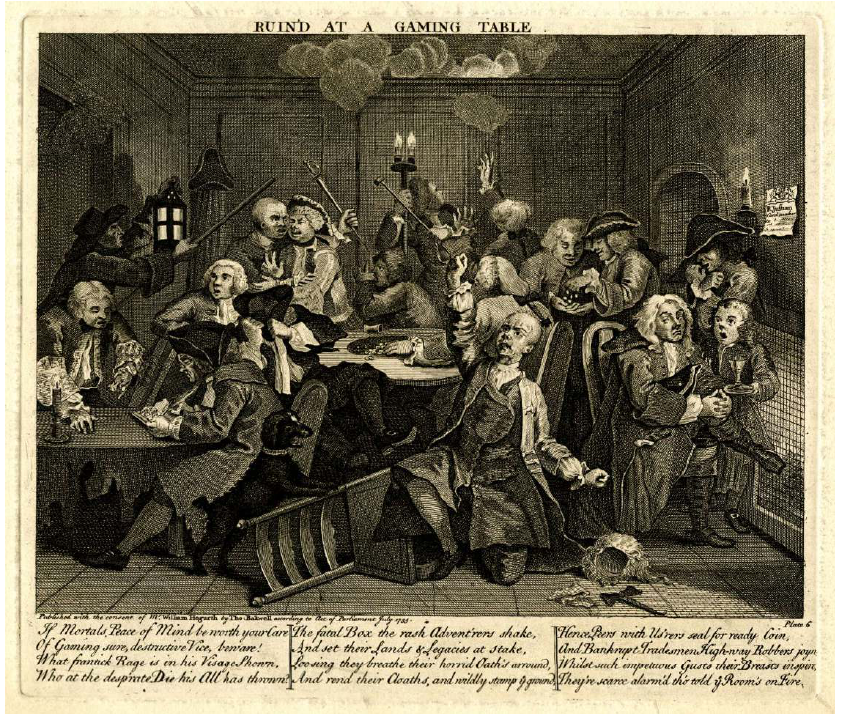
Figure 1: William Hogarth, ‘Ruin’d at a gaming table’, A Rake’s Progress , plate 6,